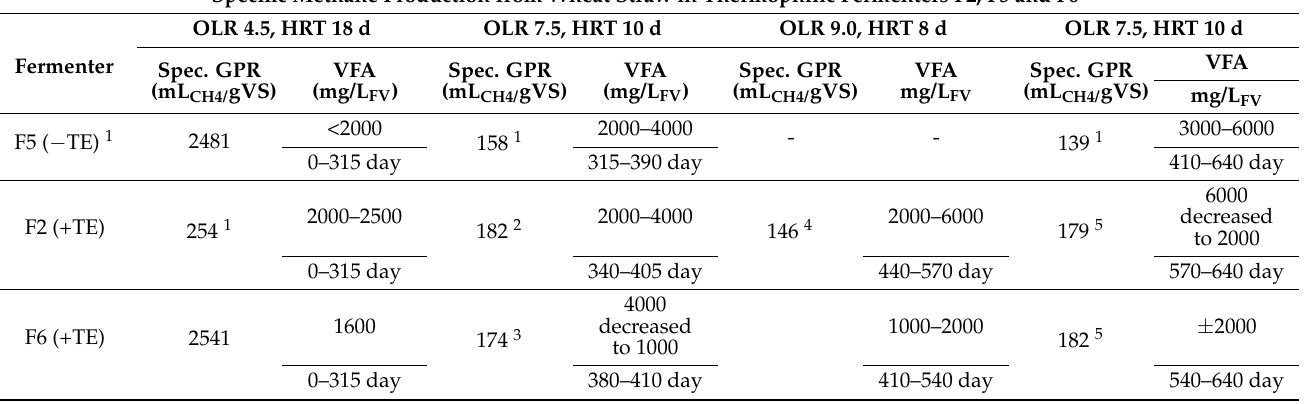
Table 7. Specific methane production (spec GPR) of three fully automatic, continuously stirred thermophilic (41 ◦ C) fermenters. They were fed exclusively with wheat straw at different loading rates in ‘synthetic manure’ and supplemented with trace elements. Reference fermenter F5 was not supplemented. All values are converted into mL under standard conditions of temperature and pressure and were related to VS (thereby, approx. 10% reduced, with respect to raw gas measurement). The OLR/HRT-values of fermenter F6 were according to Figure 3. Therefore, column 4 refers to fermentation period 3 for F6 and not to period 5, as for F2.